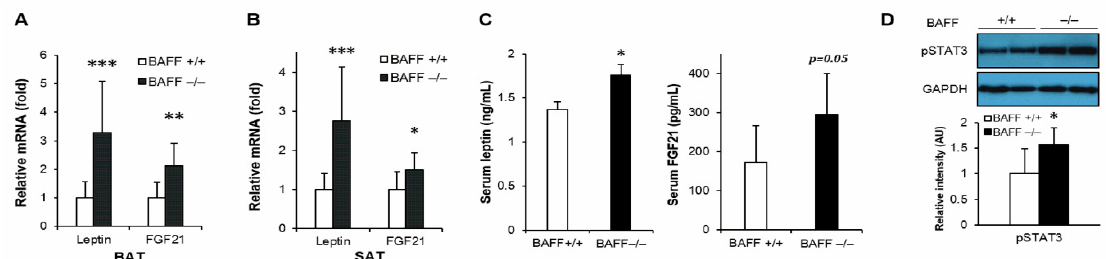
Figure 4. BAFF depletion enhances expression of leptin and FGF21 in subcutaneous and brown adipose tissues. Effect of BAFF deficiency on leptin and FGF21 mRNA expression in ( A ) BAT and ( B ) SAT ( n = 9–12). Gene expression level is normalized with mRNA expression level of Arbp. ( C ) Effect of BAFF deficiency on serum protein levels of leptin and FGF21 ( n = 6–8). ( D ) Effect of BAFF deficiency on leptin-dependent STAT3 phosphorylation in brown adipose tissue of 10-month-old mice. Proteins were extracted from BAT for SDS-PAGE-immunoblot analysis ( n = 4–5). Data represent means ± SD. * p < 0.05, ** p < 0.01, *** p < 0.001 between wild-type and BAFF -/- mice.